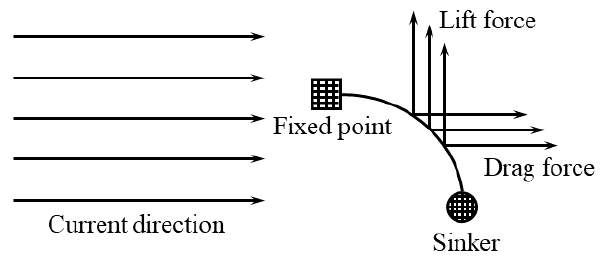
Figure 3. The load on the